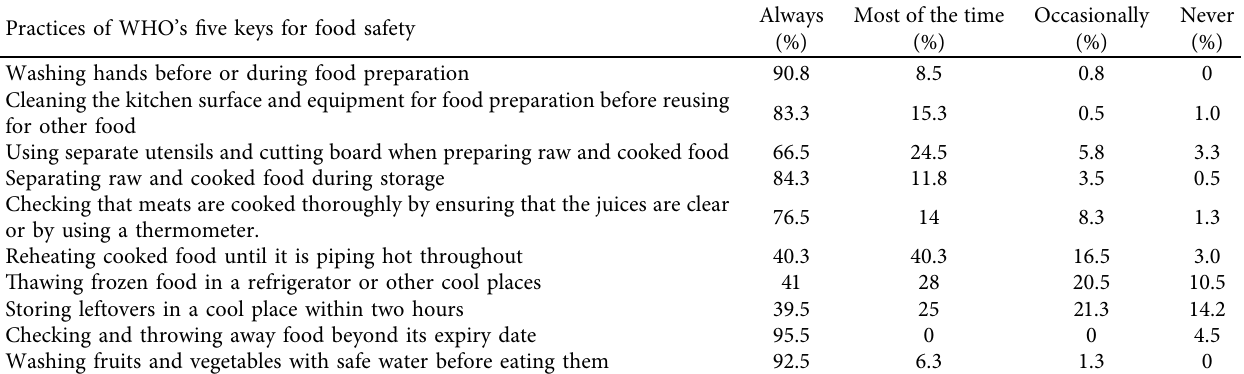
Always Most of the time Occasionally (%) (%)